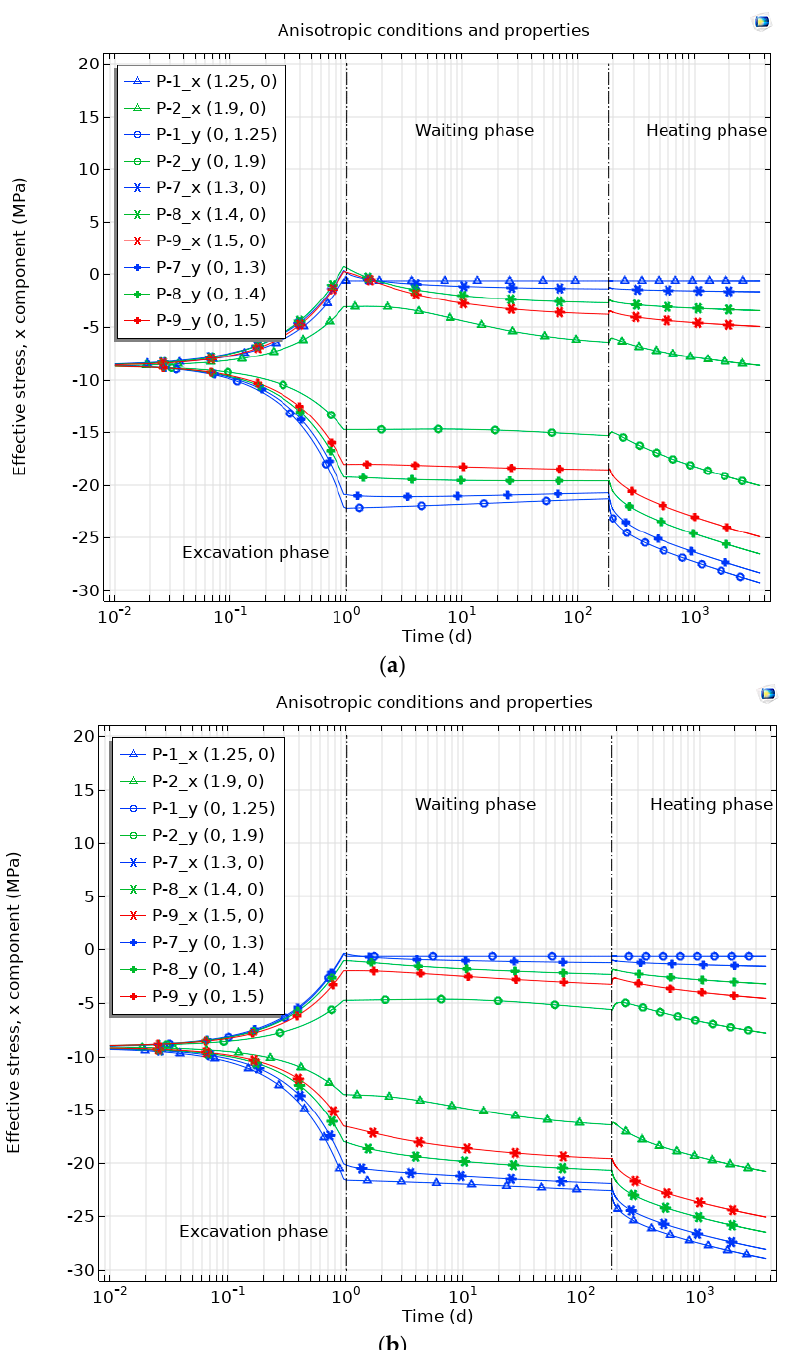
Figure 9. DC variant: evolution of the effective stress in the case of anisotropic stress conditions and anisotropic properties: ( a ) x component, ( b ) y component.